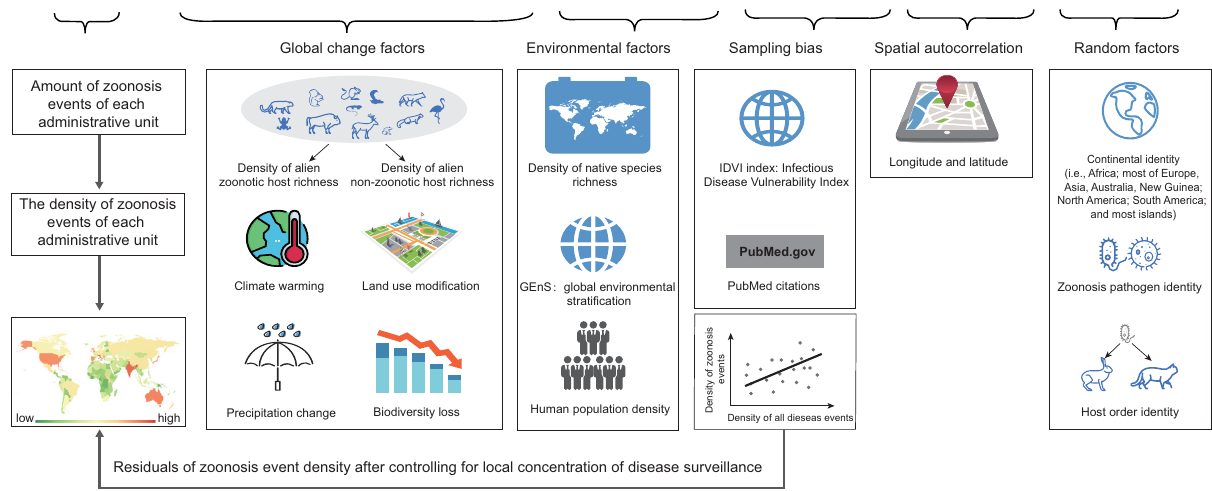
Fig. 1 Analysis diagram to estimate the effect of alien animal invasions on zoonosis emergences at the global scale. The role of alien animal zoonotic hosts was determined by accounting for global change factors ( H x1-x6 ), environmental factors ( I x7-x9 ), sampling bias ( J x10,11 ), spatial autocorrelation ( L lat , lon ), and a lack of independence among zoonoses by treating pathogen, host order and continent as random factor intercepts ( ε x14-x16 ). Thin-plate spline smooths for each predictor variable are designated by S (), and α , β , γ , δ , and Z are constants ( α is an intercept and β , γ , δ and Z represent the coef fi cient estimates of different predictor variables, and ε represents the random effects). Silhouettes were freely obtained from “ islide ” plug-in